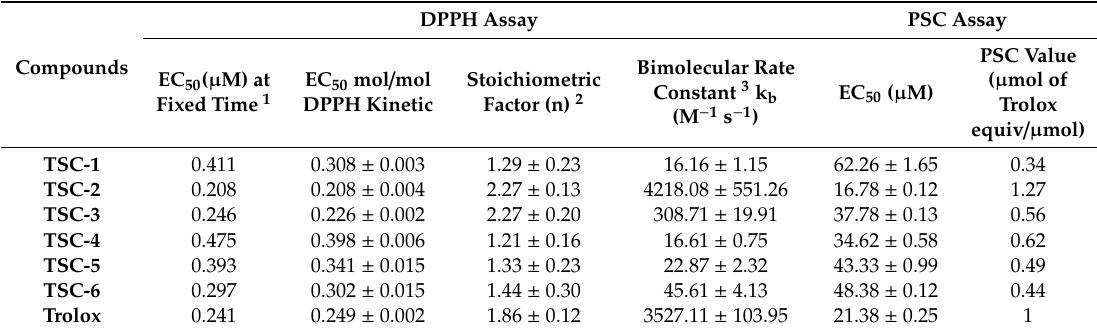
Table 1. Scavenging radical activities of compounds TSC-1~6.